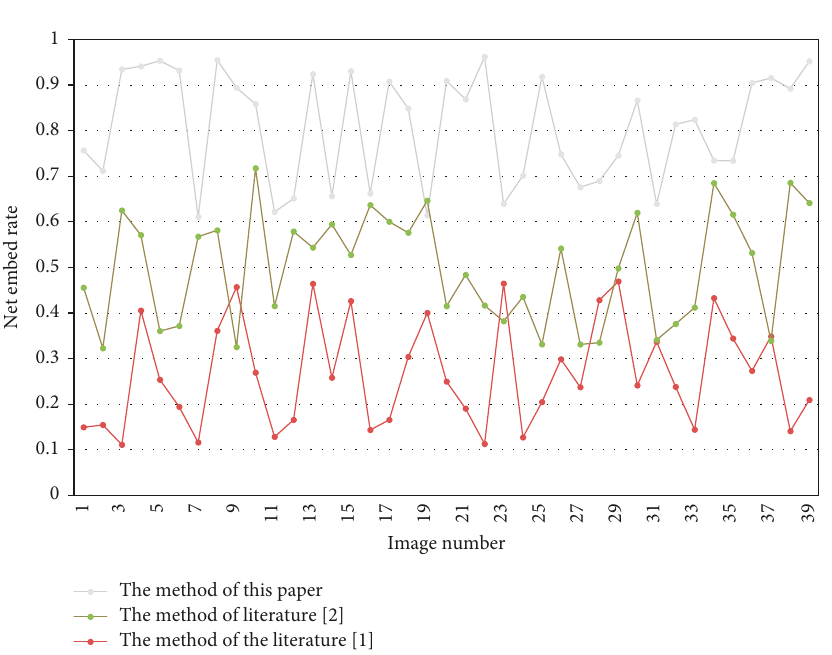
Figure 7: Statisticsof the comparative test